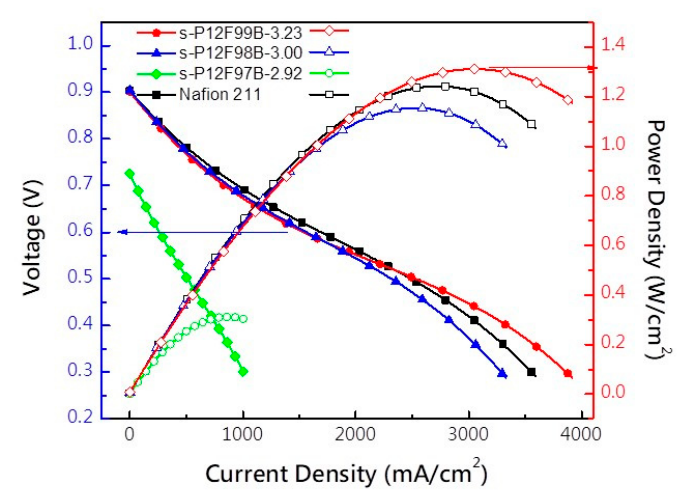
Figure 8. Fuel cell performance of s-P12F99B-2.89, s-P12F98B-3.00, s-P12F97B-2.92 and Nafion 211 membranes at 80 °C .